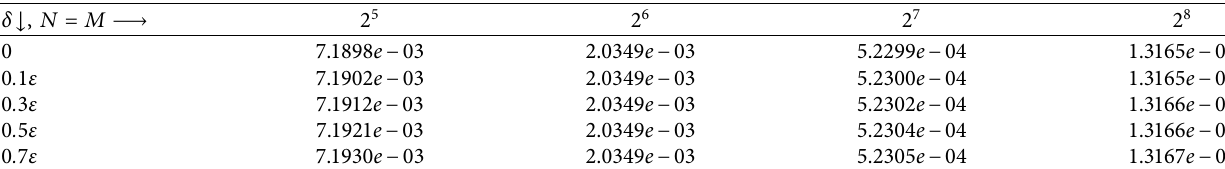
Table 3: Maximum absolute error of Example 1 using the proposed method for different values of delay parameter at ε � 2 − 10